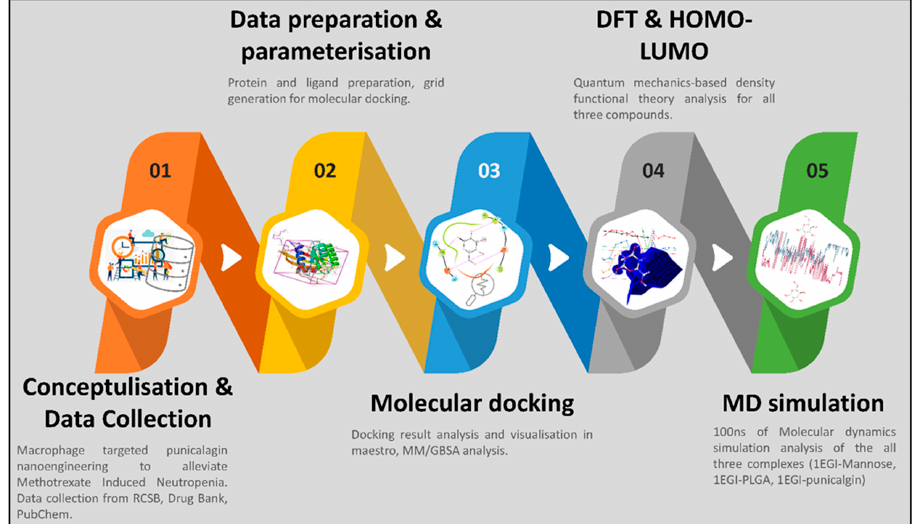
Figure 1. The graphical abstract of the methods for the complete study.